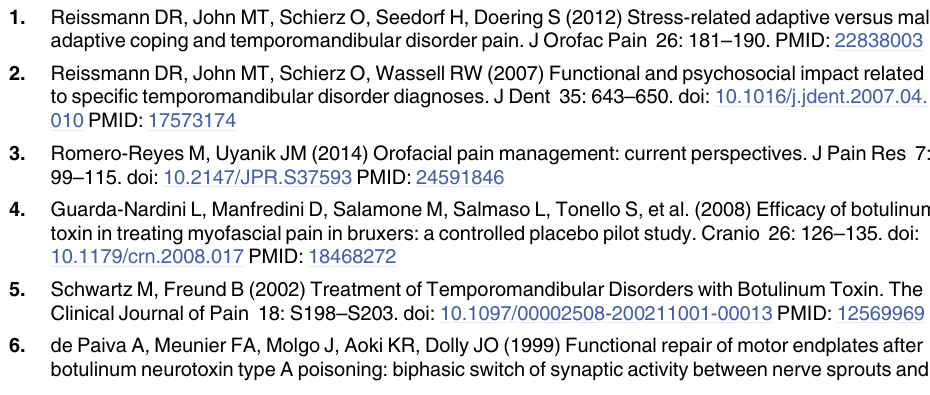
S1 Fig. Col10a1 expression, TRAP distribution and proteoglycan secretion in condyles of saline injected mice. Sagittal sections of condyles of saline injected mice. Col10a1 expression and calcein labeling (A) , TRAP staining (B) and Toluidine Blue staining (C) . (TIF) S2 Fig. Histological quantification. A) Red pixels selected using Adobe Photoshop for quanti- fication of Col10a1 positive cells in the MCC area. B) Yellow pixels selected for quantification of TRAP positive cells in the subchondral bone. C) Toluidine blue stained area quantified. D) Quantification of toluidine blue distance mapping.